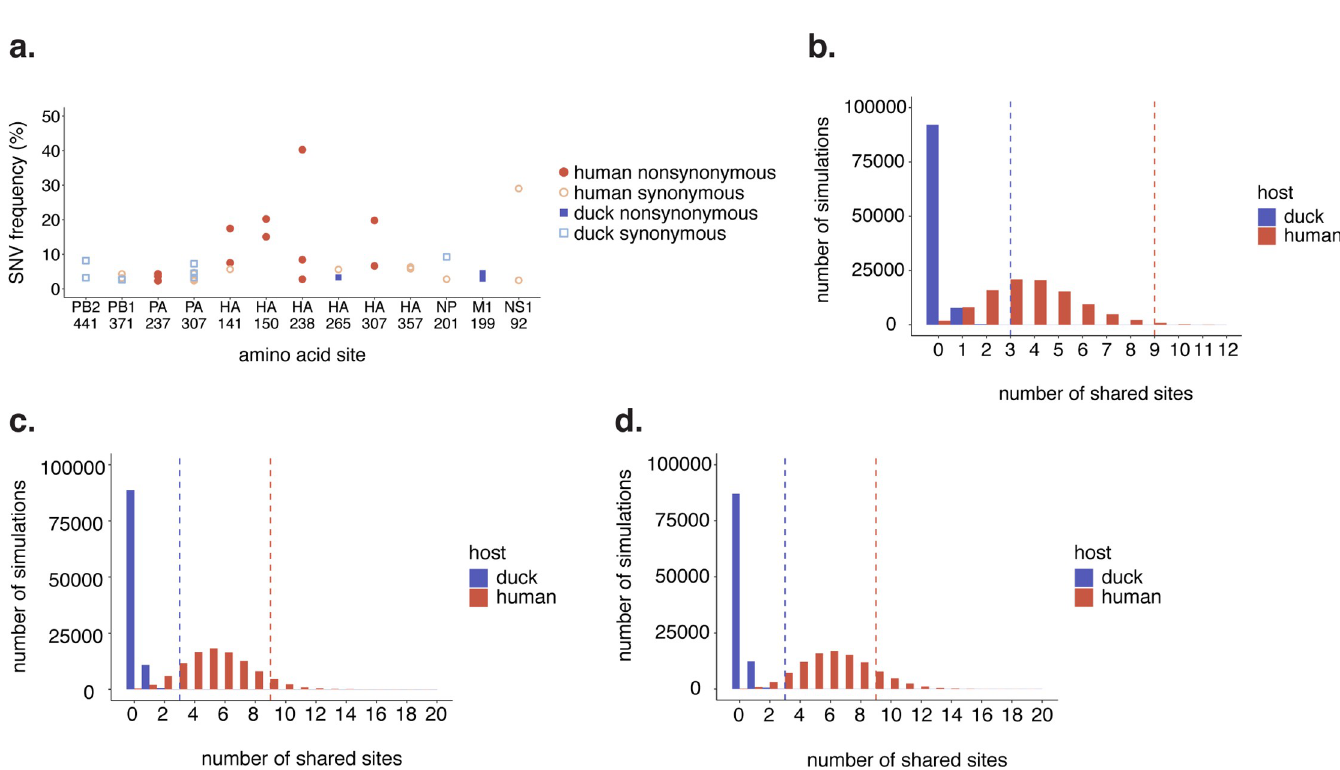
Fig 5. Ducks share more polymorphisms than expected by chance. (a) All amino acid sites that were polymorphic in at least 2 samples are shown. This includes sites at which each sample had a polymorphism at the same site, but encoded different variant amino acids. There are 3 amino acid sites that are shared by at least 2 duck samples, and 9 polymorphic sites shared by at least 2 human samples. 3 synonymous changes are detected in both human and duck samples (PB1 371, PA 397, and NP 201). Frequency is shown on the y-axis. (b) To test whether the level of sharing we observed was more or less than expected by chance, we performed a permutation test. The x-axis represents the number of sites shared by at least 2 ducks (blue) or at least 2 humans (red), and the bar height represents the number of simulations in which that number of shared sites occurred. Actual observed number of shared sites (3 and 9) are shown with a dashed line. (c) The same permutation test as shown in (b), except that only 70% of amino acid sites were permitted to mutate. (d) The same permutation test as shown in (b), except that only 60% of amino acid sites were permitted to